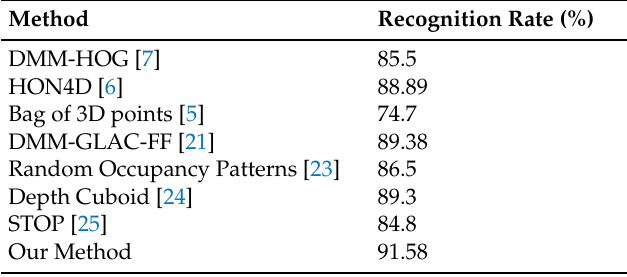
Table 8. The recognition accuracy comparison with other methods on MSR-Action3D.